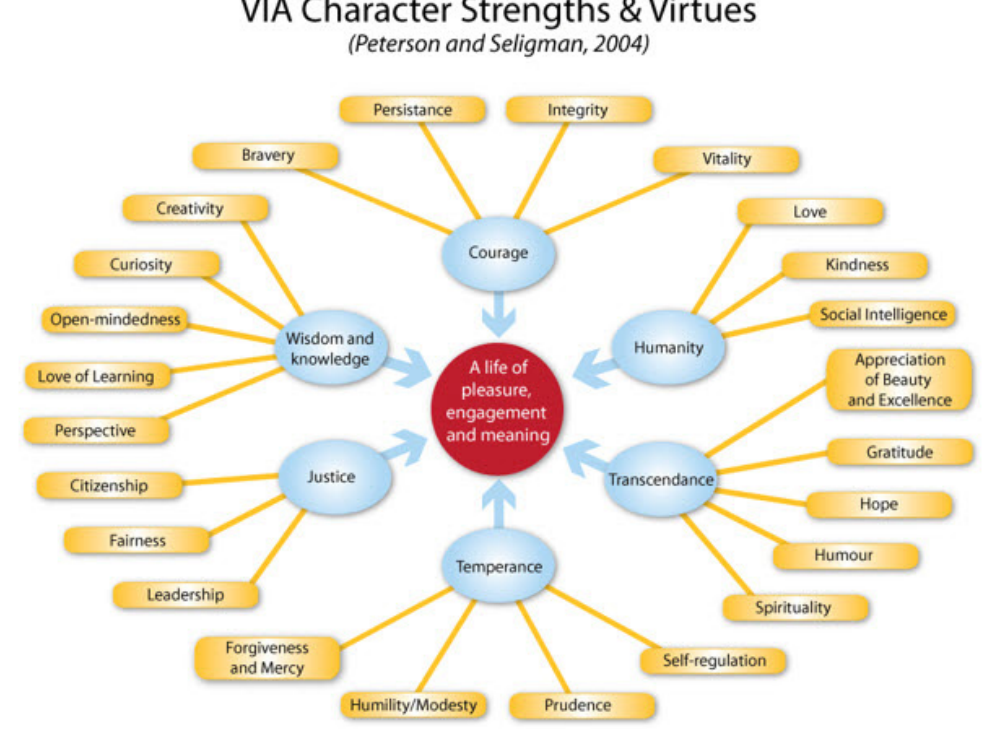
Figure 2. VIA list of 24 Character Forces and 6 virtuous categories Values in action character strengths (Peterson and Seligman,